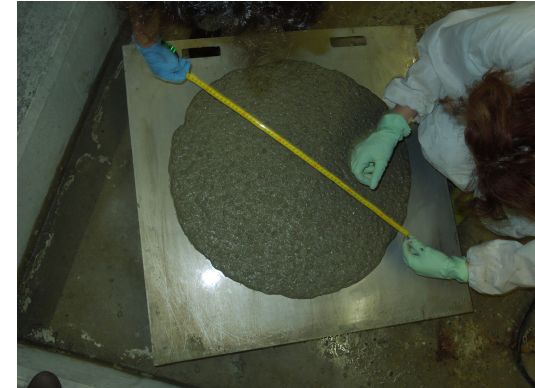
Table 2. Grading requirements in ASTM C 1567 and grading for CEN sand used.